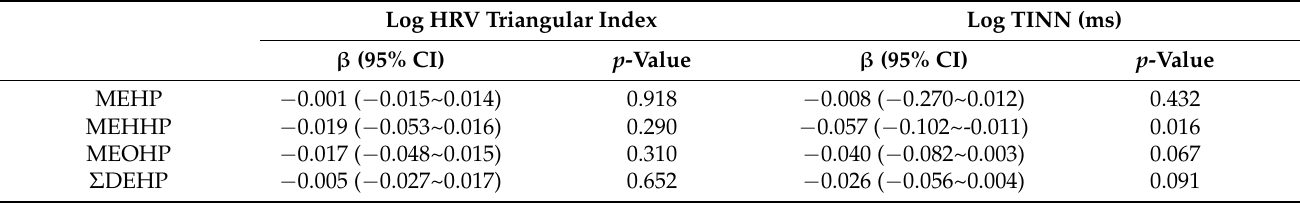
Table 5. Multivariable linear regression of urinary phthalate metabolites and frequency-domain HRV analysis parameters.